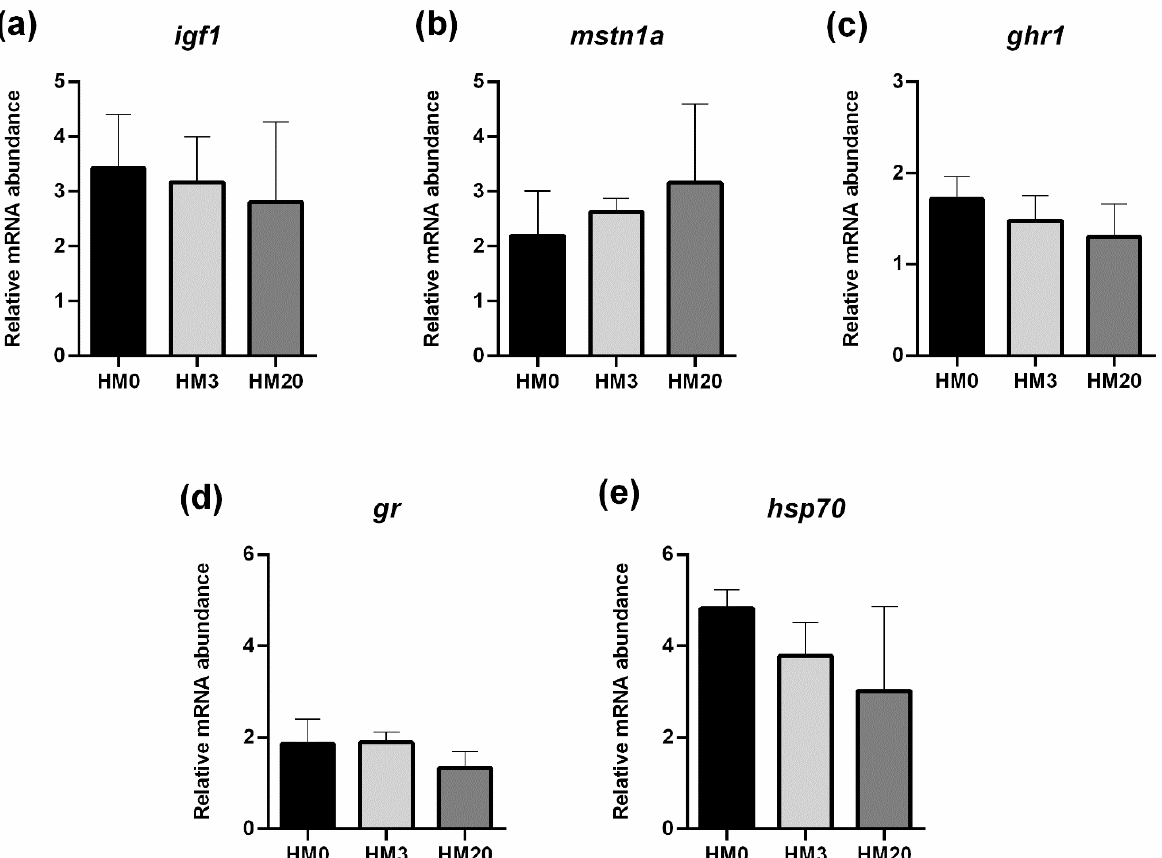
Figure 5. Relative mRNA abundance of genes involved in growth—( a ) igf1 ; ( b ) mstn1a ; ( c ) ghr1 —and stress response—( d ) gr and ( e ) hsp70 —analyzed in liver samples of rainbow trout fed the experimental diets. Values are shown as mean ± SD ( n = 9). Pyloric caeca. Considering elovl2 and fads2 gene expression (lipid metabolism; Figure 6a,b), no significant differences were observed among the experimental groups.